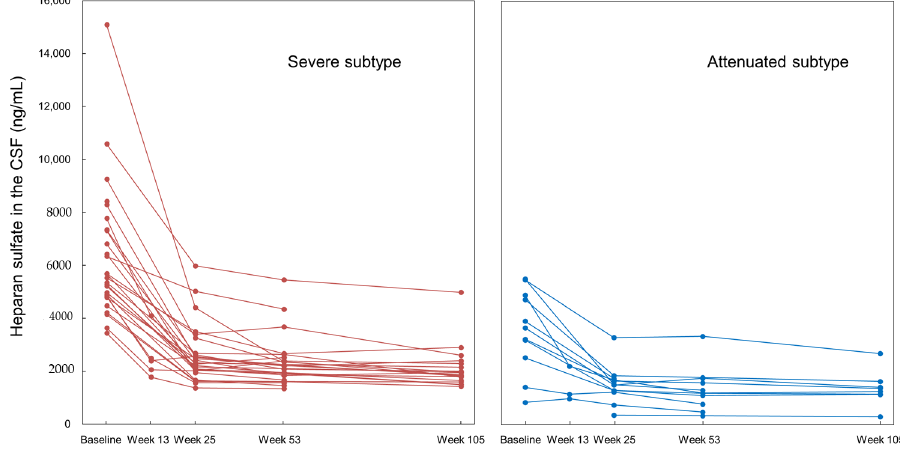
Figure 7. Reductions in the HS concentrations in the CSF of patients with severe and attenuated subtypes of MPS II in phase II and II/III studies.